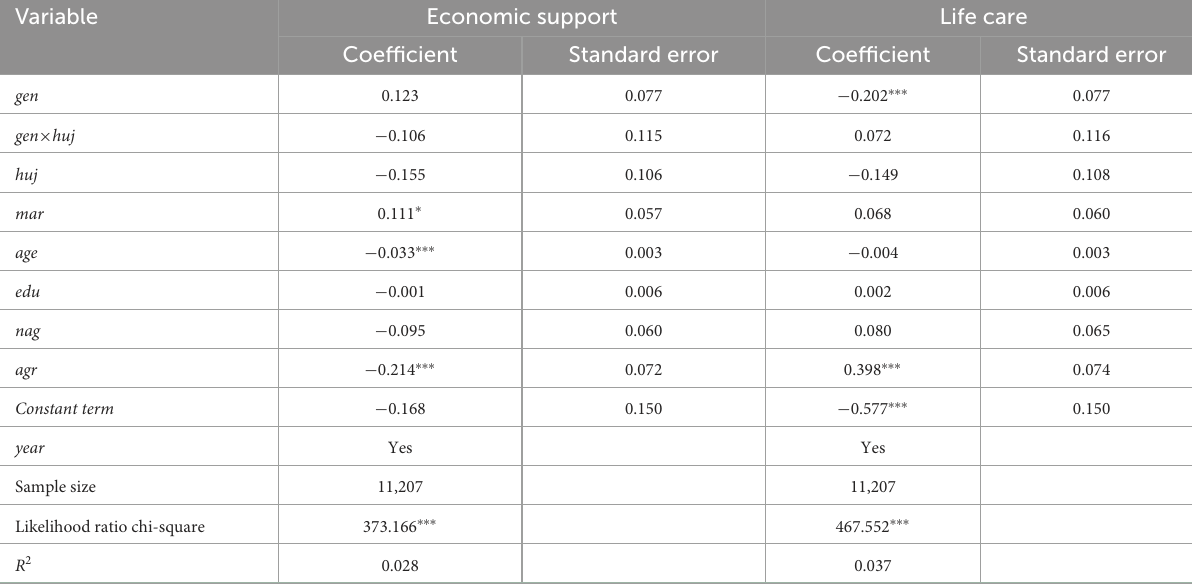
TABLE 5 Estimated results of urban–rural differences based on children’s gender and level of parental